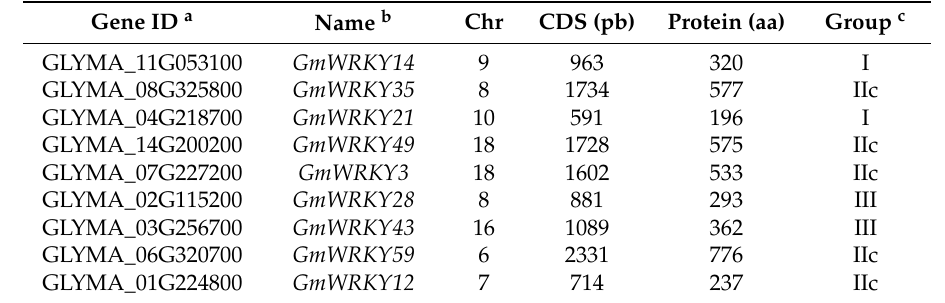
Table 2. Annotation of Glycine max WRKY transcription factors responding to salt stress